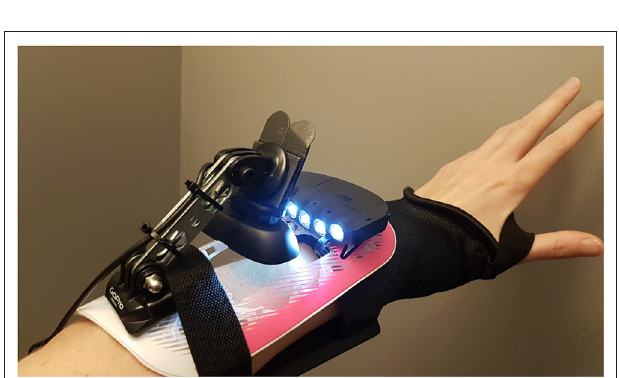
FIGURE 4 | Custom made set-up of a wearable camera for recording a video of participant’s skin for identifying goosebumps and